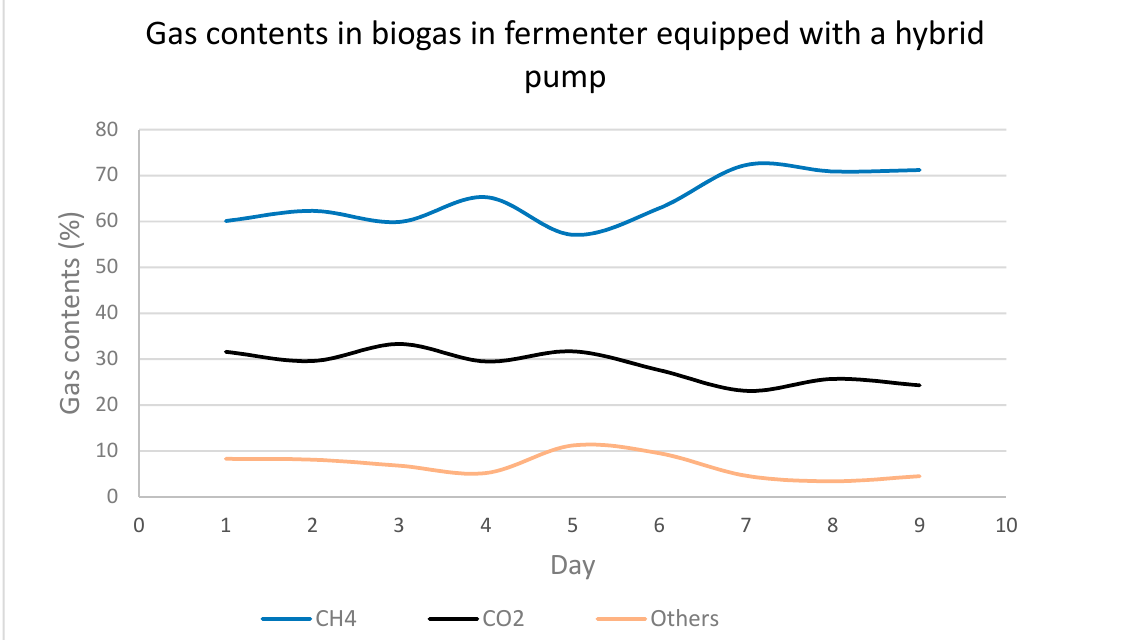
Figure 5 . Increase in methane content in biogas produced in a fermenter with a hybrid pump after starting the fermenter.